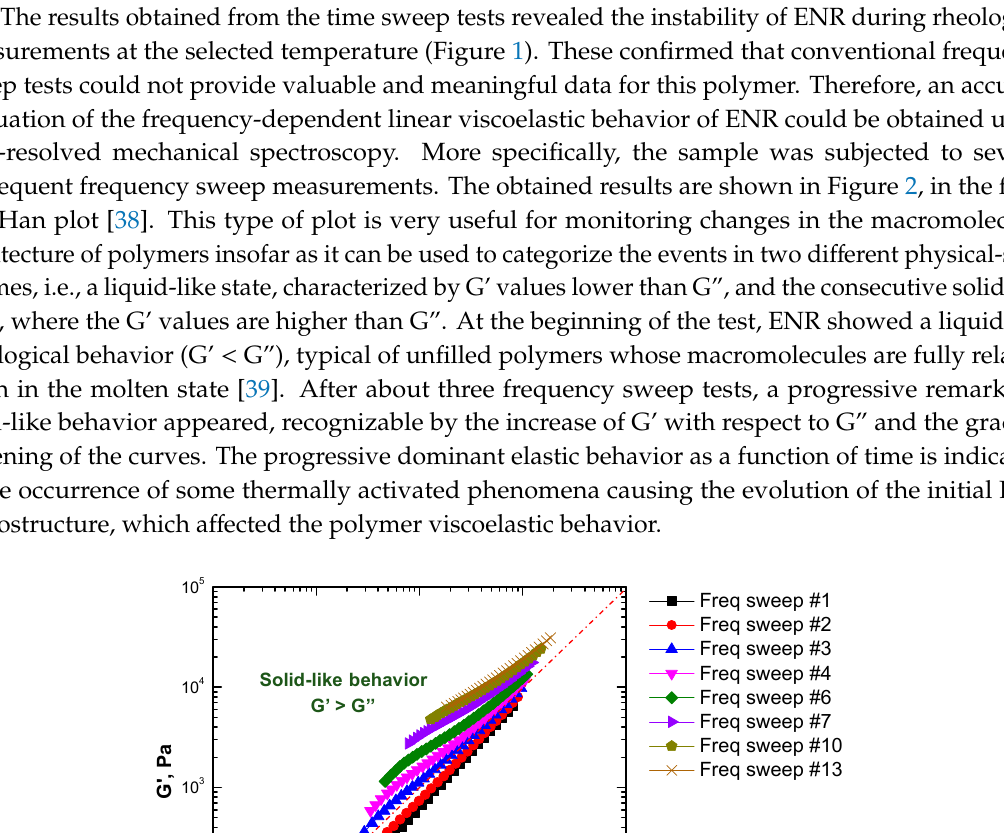
Figure 2. Curves of G’ vs. G” at 180 °C for ENR25 subjected to subsequent frequency sweeps.